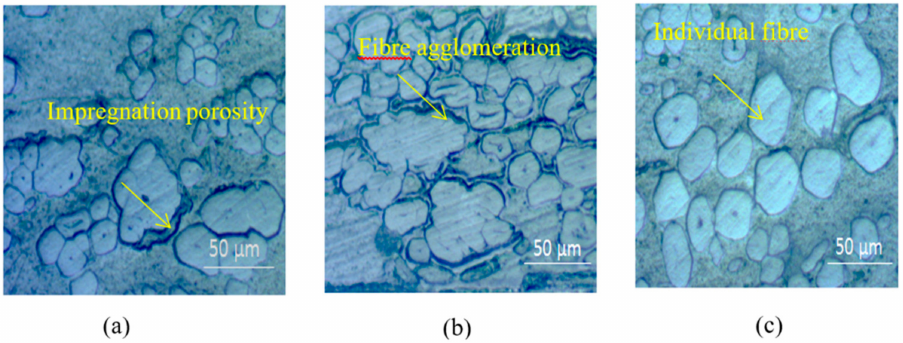
Figure 5. Optical micrographs for cross-sections of ( a ) B-flax, ( b ) E-flax, and ( c ) P-flax composites ( ×